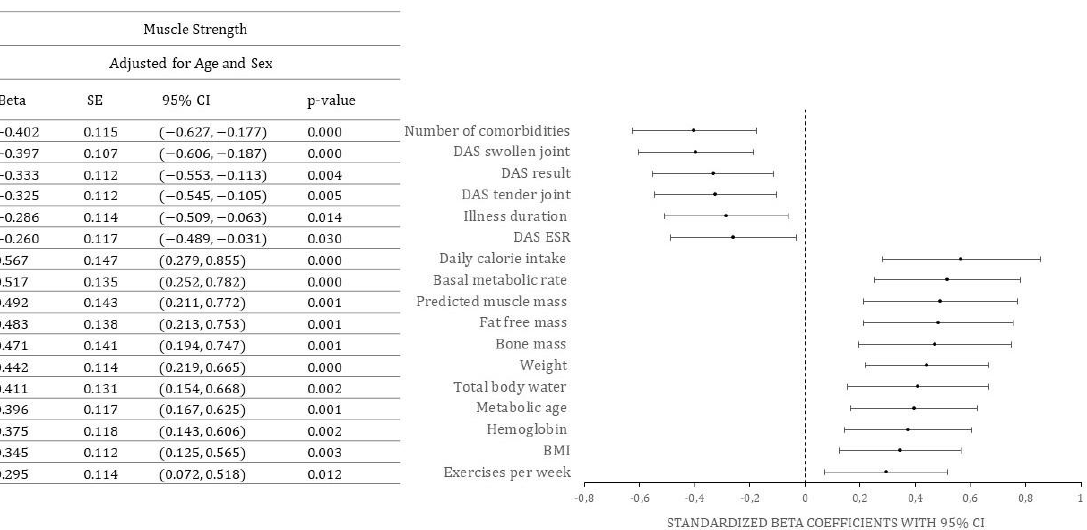
Figure 1. Predictors of muscle strength. Abbreviations: SE-standard error, CI-confidence interval, DAS-disease activity score, DAS ESR-disease activity score erythrocyte sedimentation rate, BMI-body mass index (kg/m 2 ).